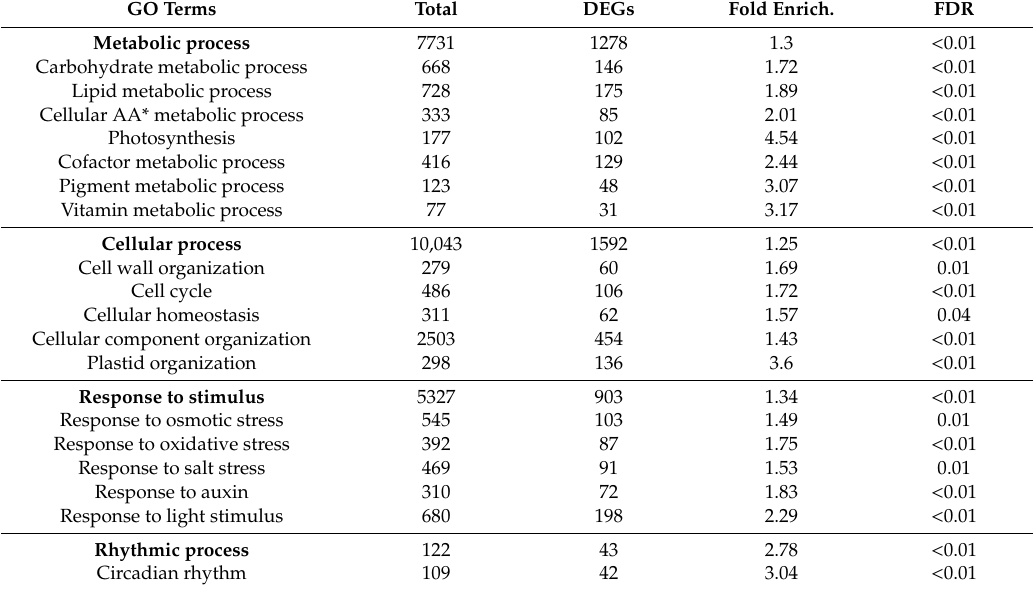
Table 2. Selected GO terms (biological process) for downregulated genes in i-hpHSP90C transgenic line after Dex